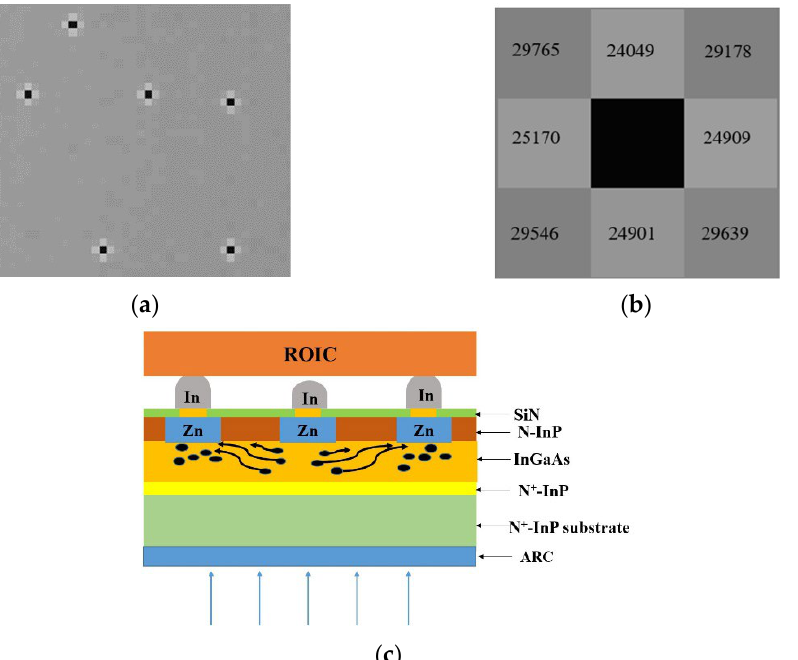
Figure 2. ( a ) scatter diagram of Inoperable pixels. ( b ) Response gray value of electrical crosstalk of inoperable pixel. ( c ) The schematic diagram of electrical crosstalk of inoperable pixel.